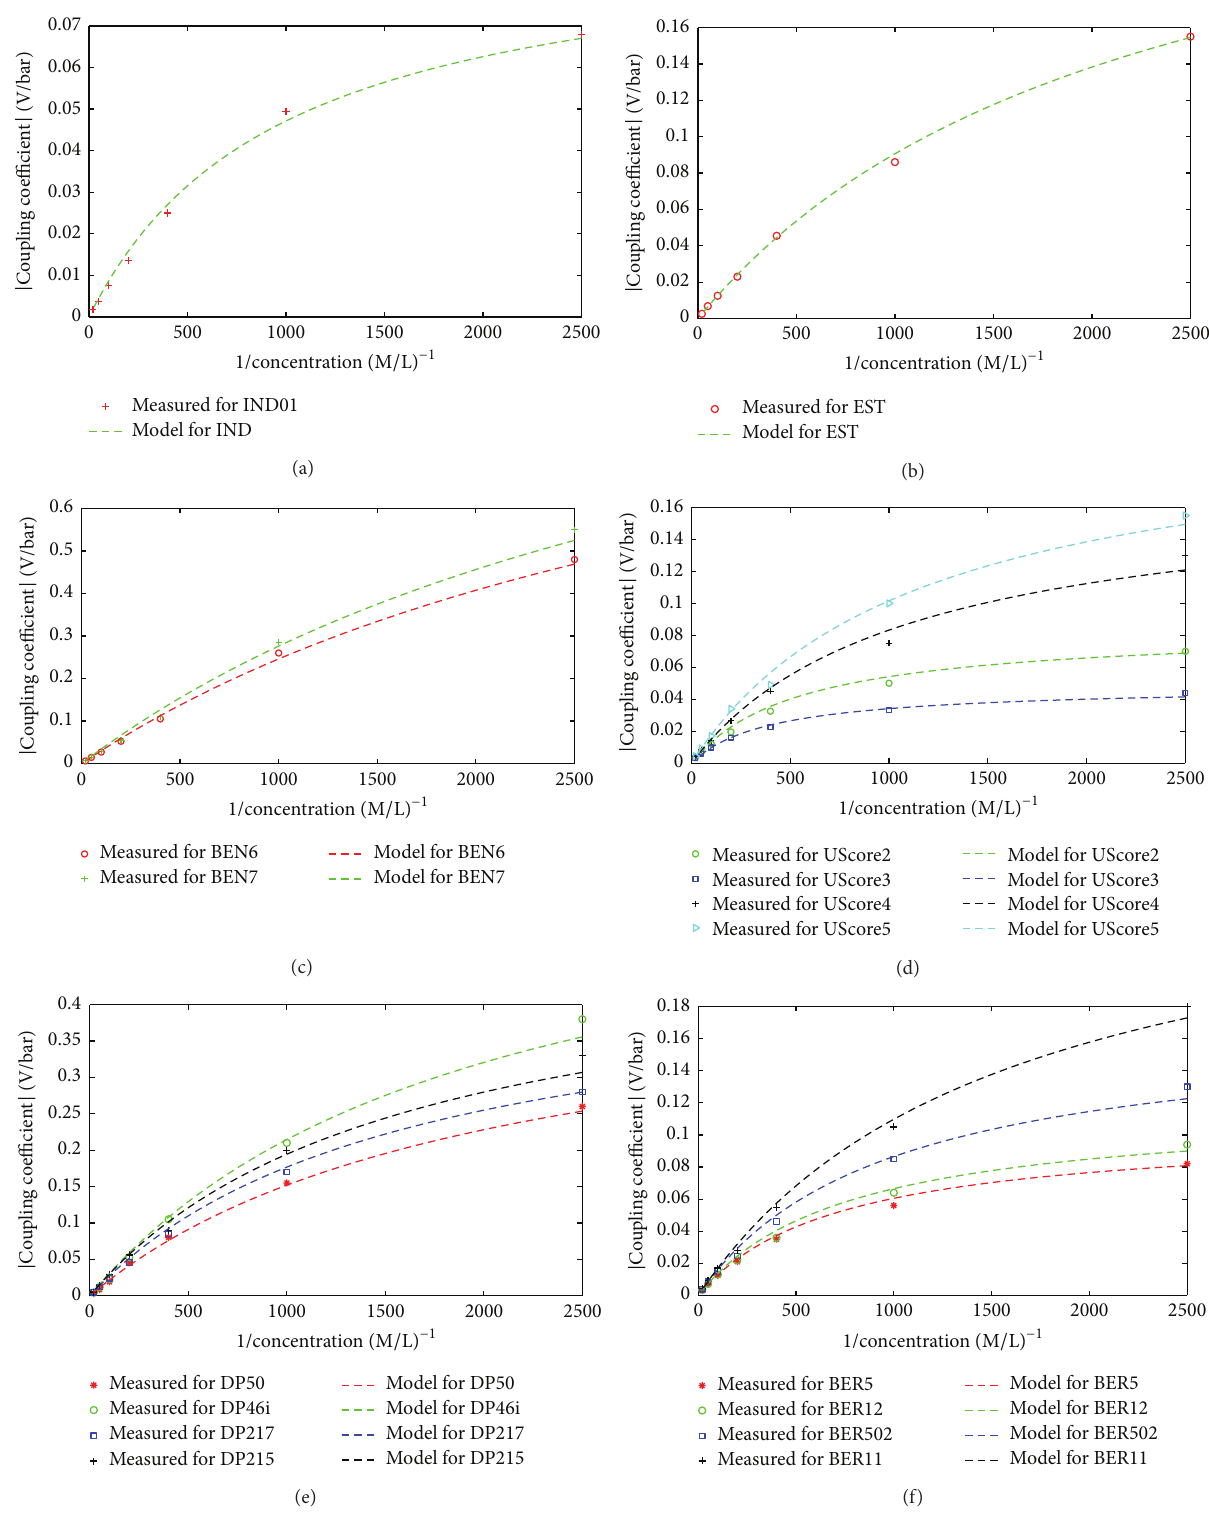
Figure 5: (a) is for the IND01 sample with 𝑐 = 3 × 10 −28 S m 2 /site, (b) is for the EST sample with 𝑐 Prot = 3 × 10 −28 S m 2 /site, (d) is for the set of BereaUS samples with 𝑐 BEN6 and BEN7 samples with 𝑐 Prot = 3 × 10 −28 S m 2 /site, and (f) is for the set of BER samples with 𝑐 set of DP sample with 𝑐 Prot the model for all